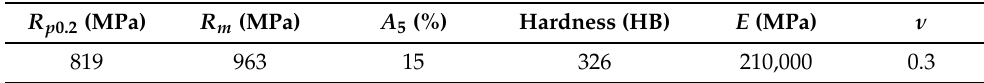
Table 3. Mechanical properties of the tested material 34CrNiMo6 [39]. R p 0.2 (MPa)